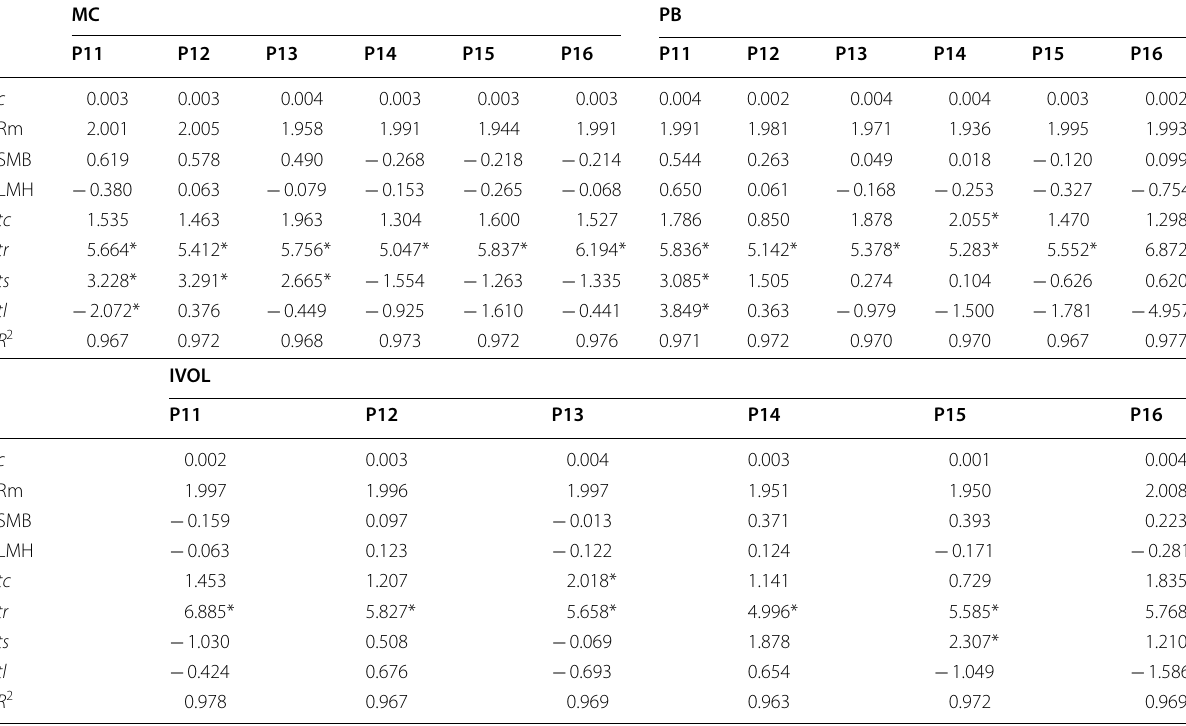
Table 5 Regression results of Fama–French’s three-factor model for six portfolios R Pt − R Ft = a + b ( R Mt − R Ft ) + s